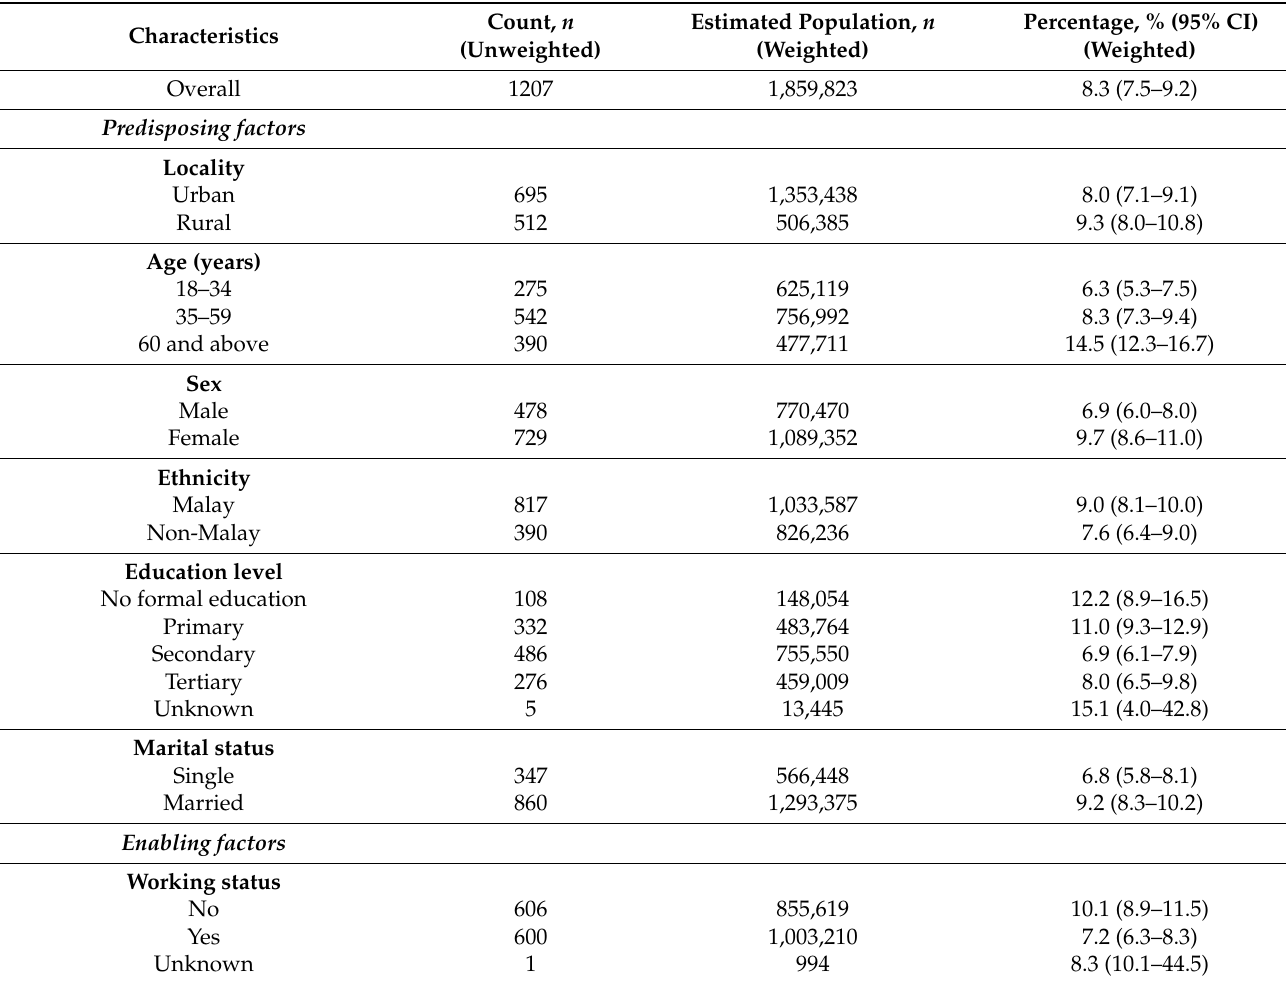
Table 2. Prevalence of the outpatient care users (N =